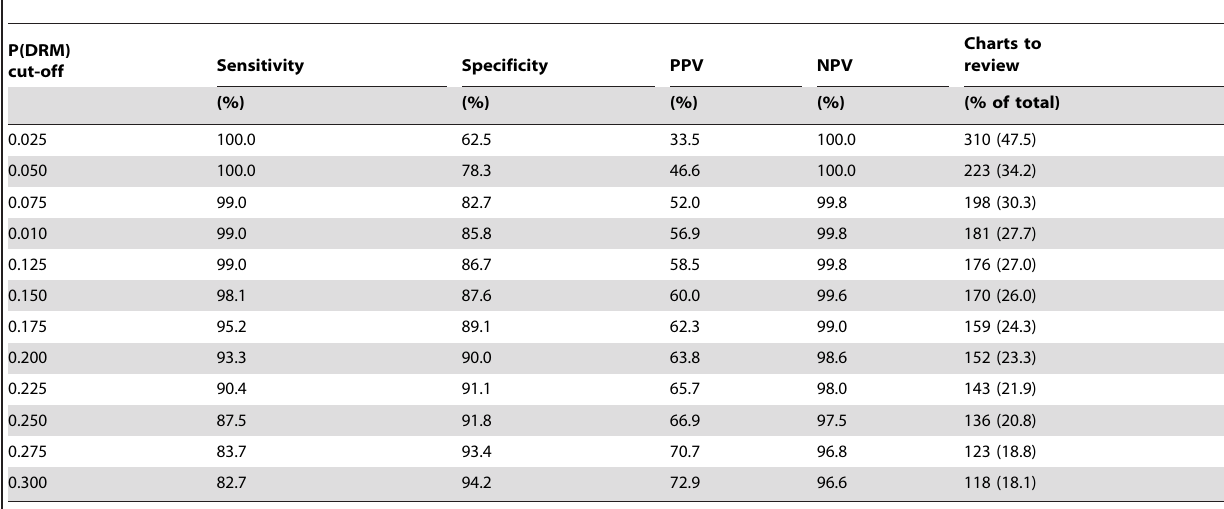
Table 3. Model classification results with different predicted probability